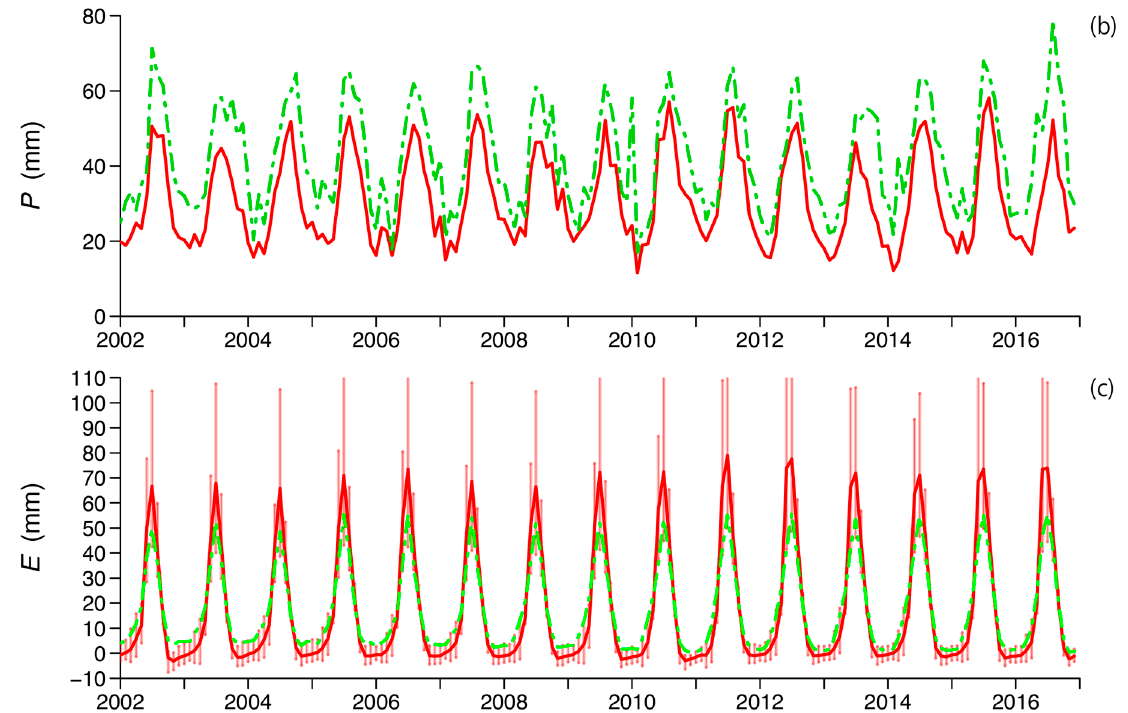
Figure 3. Temporal variations in the monthly hydro-meteorological factors, namely, the ( a ) 2-m air temperature ( T aM ), ( b ) P , and ( c ) E , of the Arctic circumpolar tundra region from 2002 to 2016. Vertical red lines denote the maximum and minimum range of GLDAS1-based E .